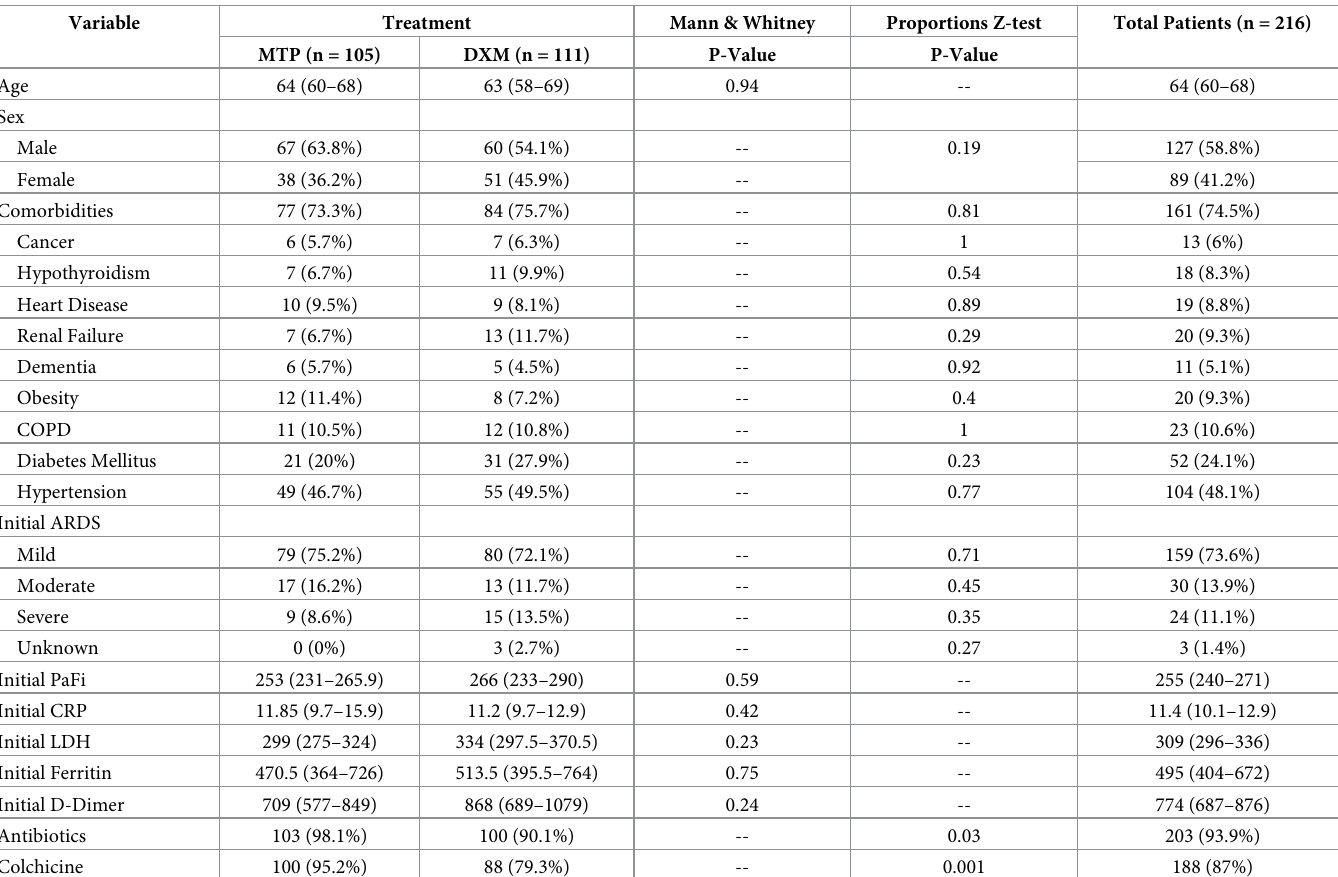
Table 1. Sociodemographic and clinical characteristics of hospitalized patients with Covid-19 pneumonia, according to treatment